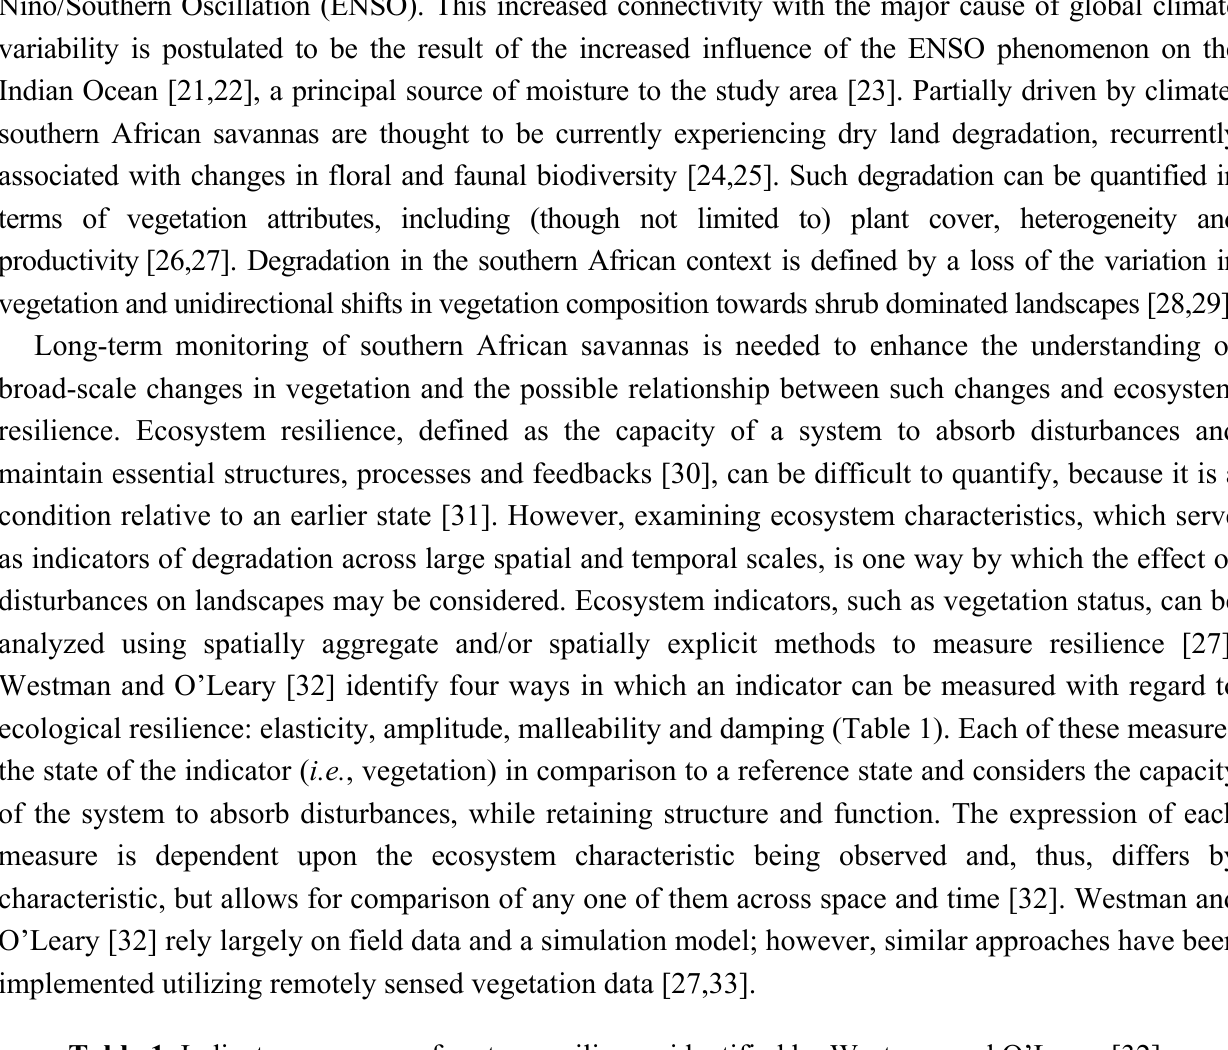
Table 1. Indicator measures of system resilience, identified by Westman and O’Leary [32], modified from Washington-Allen et al.